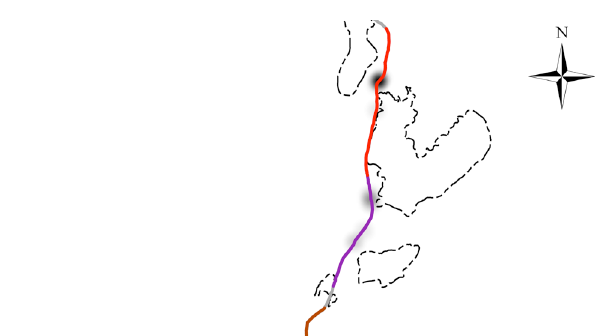
Figure 2. Encounter rate of Rhesus Macaque on the line